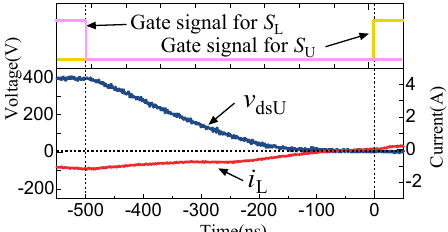
Figure 10. Zoomed waveforms around critical switching transient with the operating point at the experimental minimal switching current indicated as point D in Figure 8a.